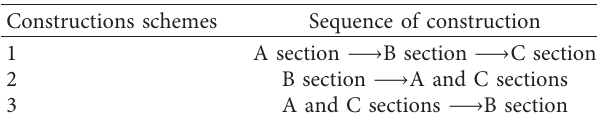
Table 2: Construction methods.